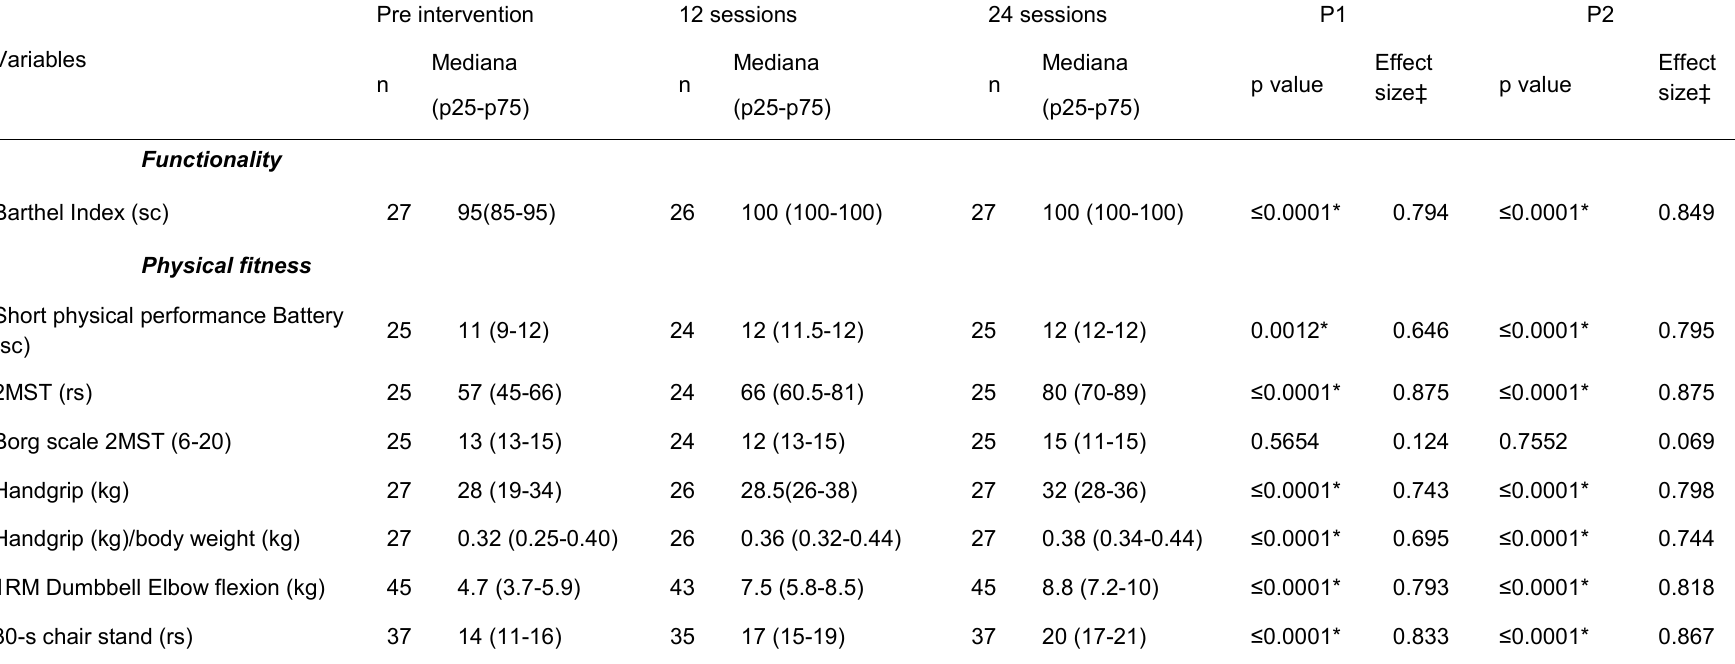
Modifications on Functionality and Physical Fitness at 12 and 24 Sessions